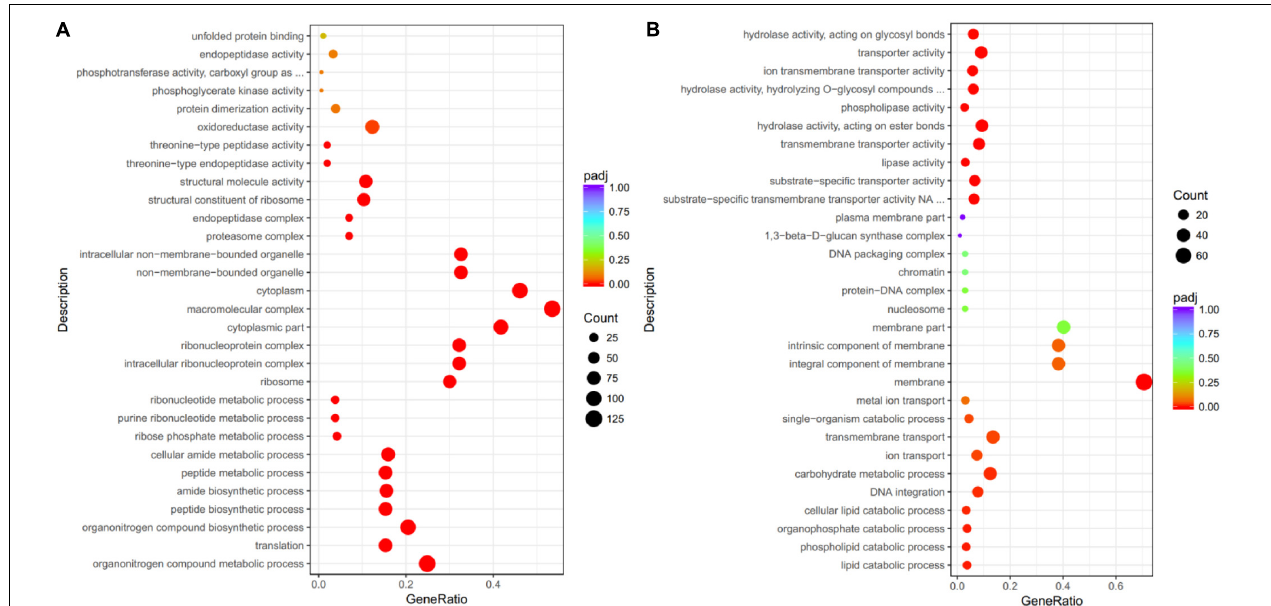
FIGURE 2 | Gene ontology (GO) annotation for DEGs. The DEGs were categorized by their GO annotations and classified into three main categories: biological process, cellular component, and molecular function. (A) Significantly co-upregulated DEGs upon Pt infection were enriched in biological process of “oxidoreductase activity” and predicted to be localized in “macromolecular complex”. (B) For DEGs highly expressed in germ tubes of Pt uredospores, genes were annotated with “transporter” activity and predicted to be localized in “membrane.” The x -axis indicates the ratio in each category.